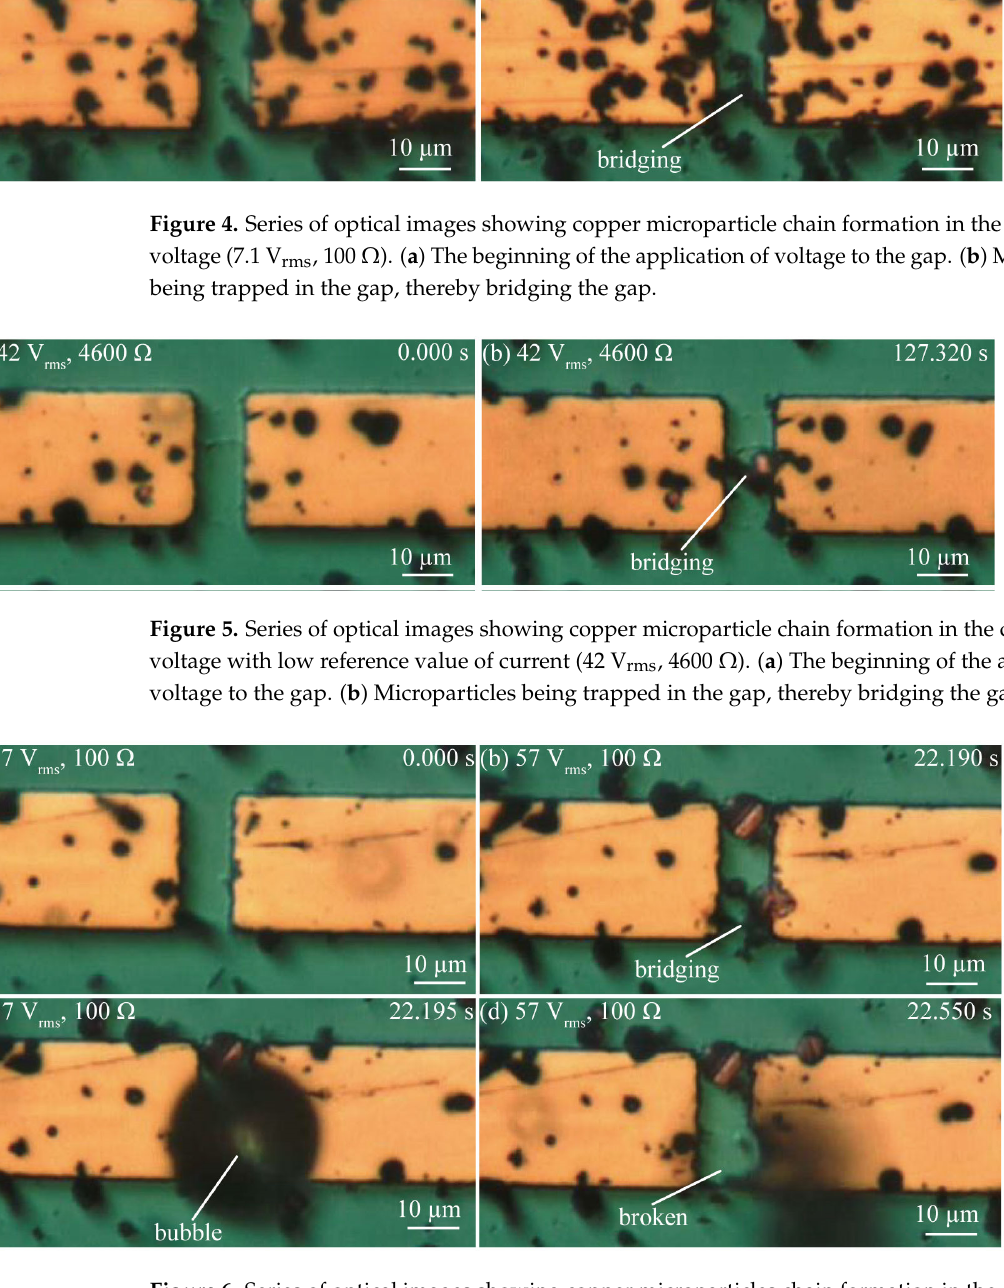
Figure 6. Series of optical images showing copper microparticles chain formation in the case of a high voltage with high reference value of current (57 V rms , 100 Ω ). ( a ) The beginning of the application of voltage to the gap. ( b ) Microparticles being trapped in the gap, thus bridging the gap. ( c ) A bubble is generated when microparticles bridge the gap. ( d ) Microparticle chain and metal interconnect are broken.